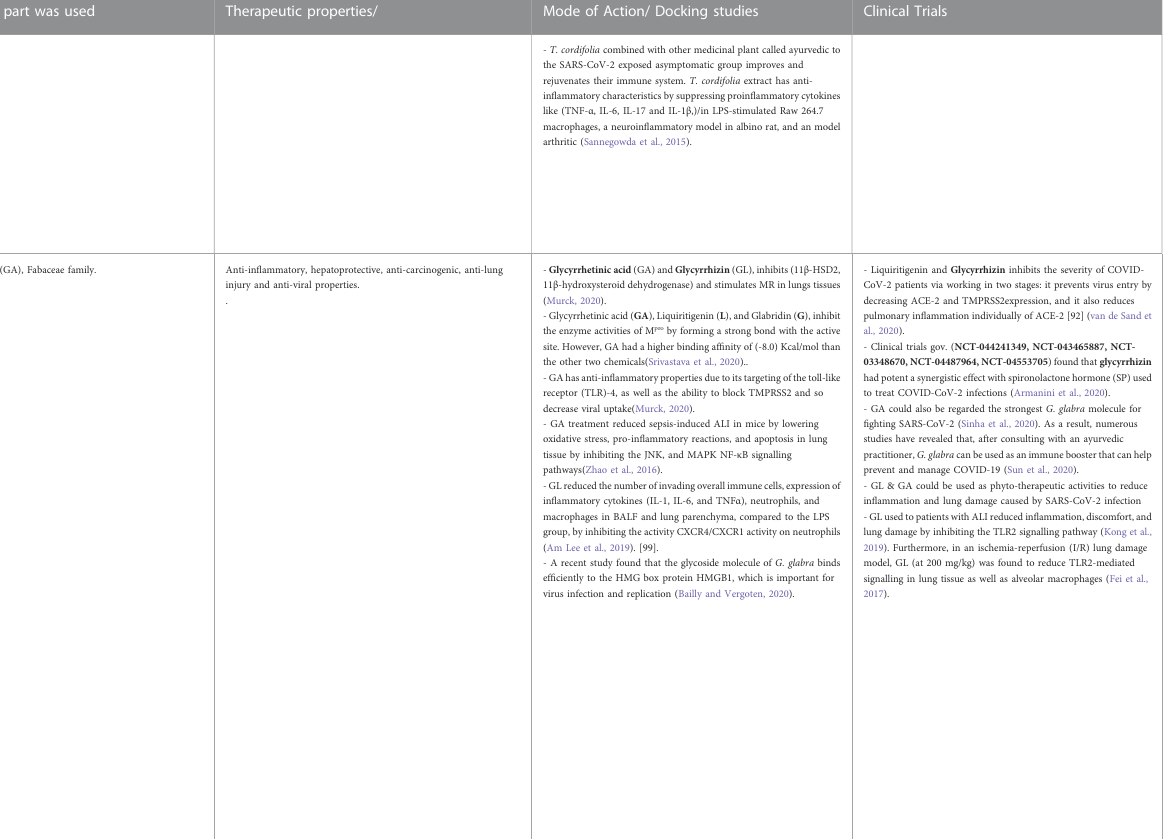
theSARS-CoV-2exposedasymptomaticgroupimprovesand rejuvenatestheirimmunesystem. T.cordifolia extracthasanti- in fl ammatorycharacteristicsbysuppressingproin fl ammatorycytokines like(TNF- α ,IL-6,IL-17andIL-1 β ,)/inLPS-stimulatedRaw264.7 macrophages,aneuroin fl ammatorymodelinalbinorat,andanmodel arthritic(Sannegowdaetal.,2015).